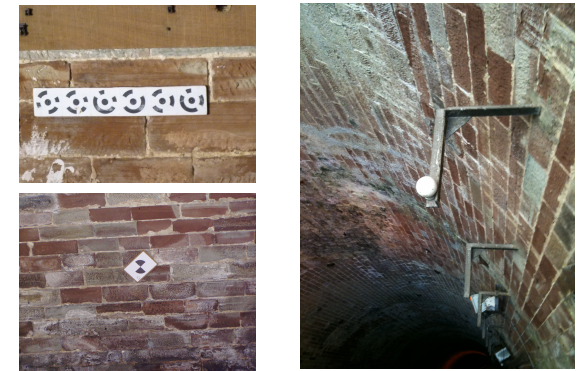
Figure 4: Encoded target for the photogrammetric model (top- left) ; black and white target (bottom-left) ; sphere (right). En- coded targets and spheres are located on the right side wall and black and white targets are fixed on the left side wall.